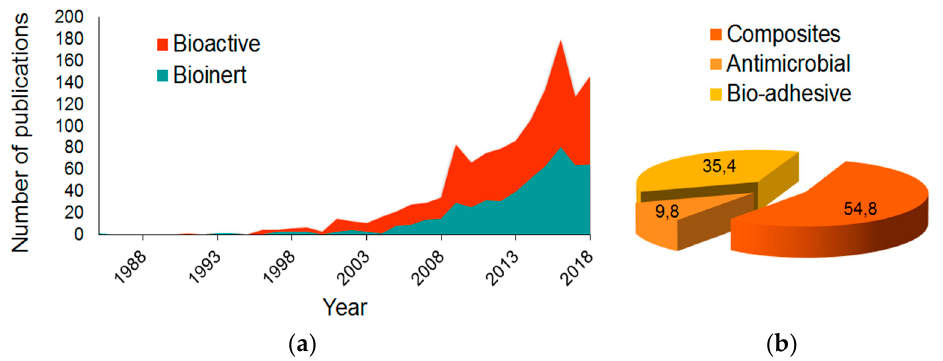
Figure 3. ( a ) Timeline of electrochemical deposition (ECD)-based coatings on titanium distinguished in bioinert and bioactive polymer films. ( b ) Pie chart relevant to the different bioactive coatings. Data source: 2019 Scopus ® .